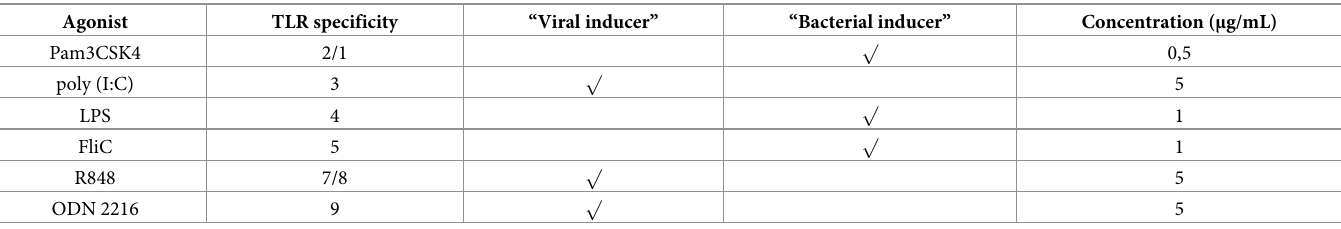
Porcine PBMC were exposed to different TLR agonists in vitro to evaluate the expression of a variety of bacterially and virally induced biomarkers. Listed is the toll-like receptor (TLR) specificity of each agonist, the dominant signalling pathway induced (viral or bacterial) and the final concentrations of agonists